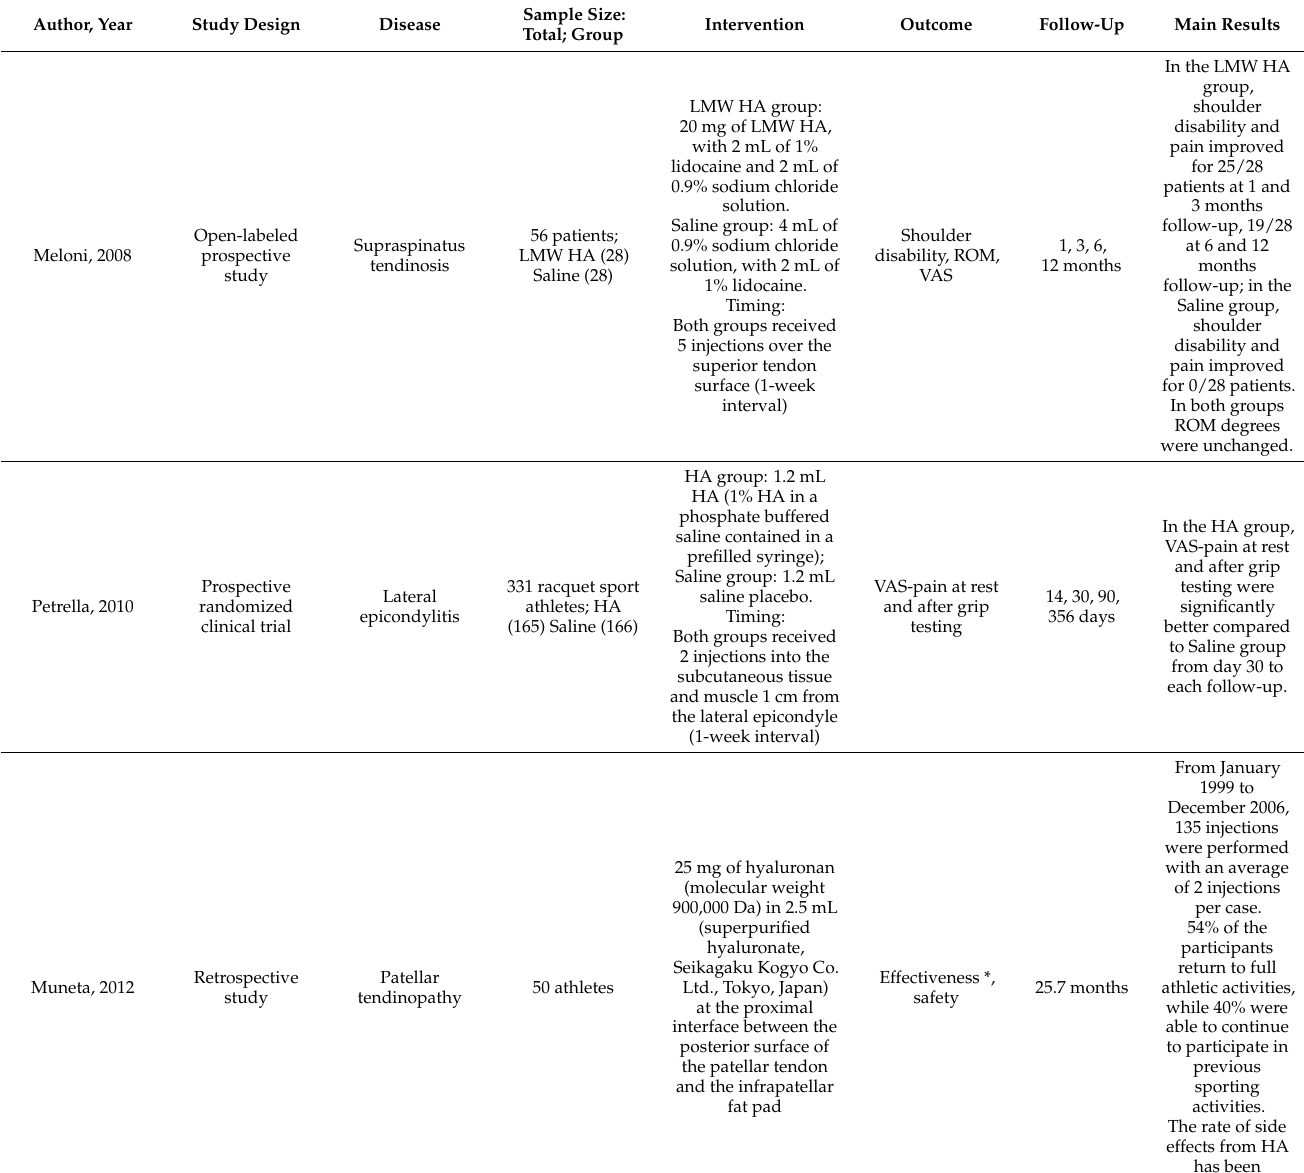
Table 1. Characteristics of the clinical studies on the HA use in